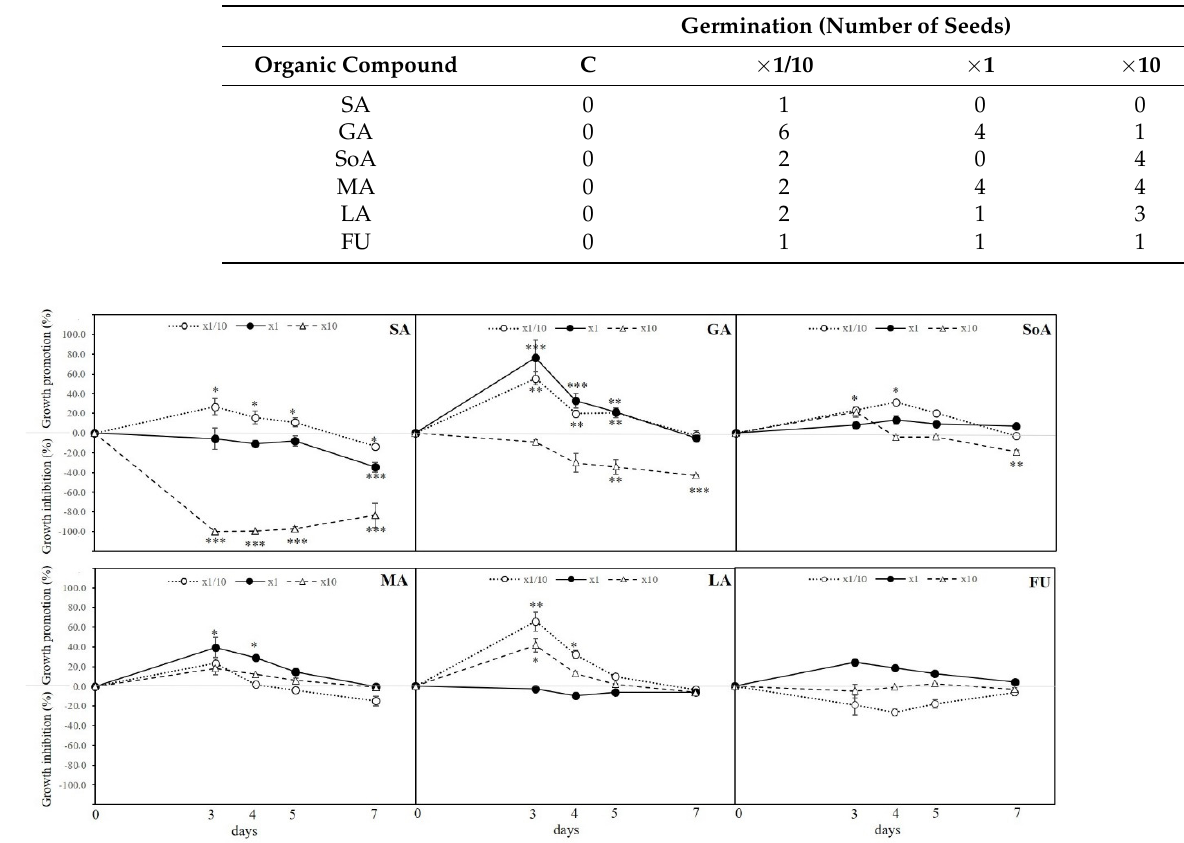
Table 2. Seeds germinated at day 2 after organic compounds (salicylic acid (SA), gallic acid (GA), sodium alginate (SoA), mannitol (MA), laminarin (LA), and fucose (FU)) application at three concen- trations ( × 1/10; × 1 and × 10). A control (C) treatment without organic compound application was performed. Sixteen seeds were sowed per treatment and doses.